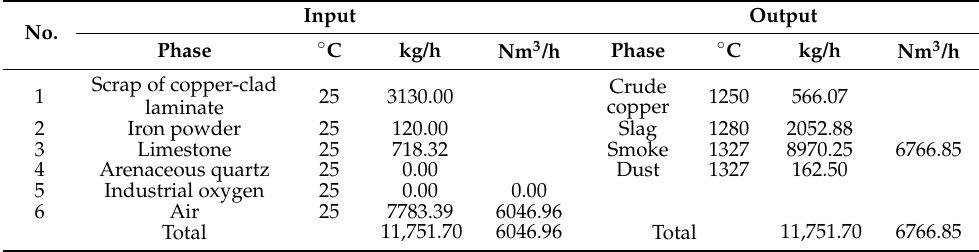
Table 2. The input–output material balance of the NRT smelting.